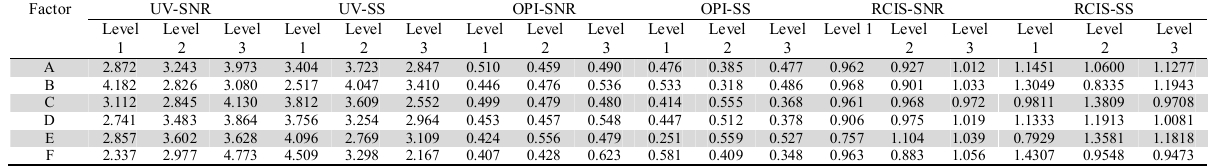
Level averages on UV-SRN, UV-SS, OPI-SNR, OPI-SS, RCIS-SNR and RCIS-SS (case study 2) Factor